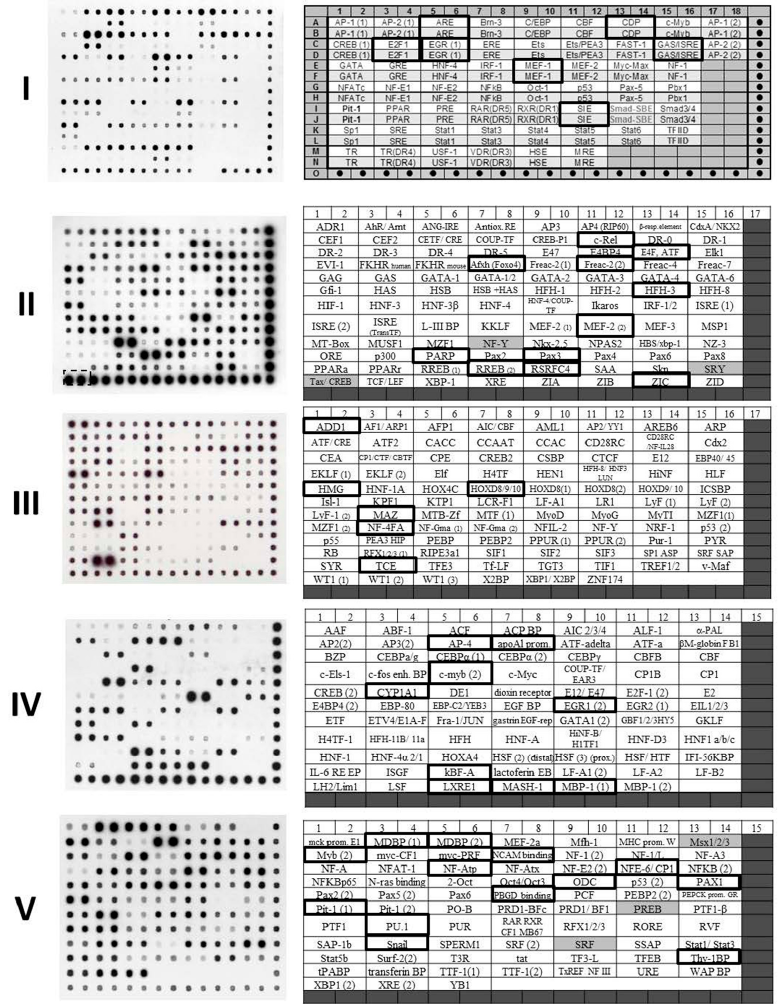
Figure 7. Transignal protein/DNA arrays using GAPDH and unalkylated DNA oligonucleotides. The experiments were performed as presented in [176]. In Transignal membrane I (labeled “I”), dot-containing boxes correspond to hybridization controls and the target sequences for each transcription factor are spotted four times: the two upper spot being 10 fold more concentrated (white boxes) than the two lower ones (light grey boxes). In Transignal membrane II to V (labeled “II” to “V”), the hybridization controls are localized in dark grey boxes and the target sequences for each transcription factor are spotted in duplicate at equal concentrations. Positions identified using black rectangles correspond to those for which a stronger GAPDH/DNA complex could be identified. The corresponding DNA sequences are presented in Table 1.